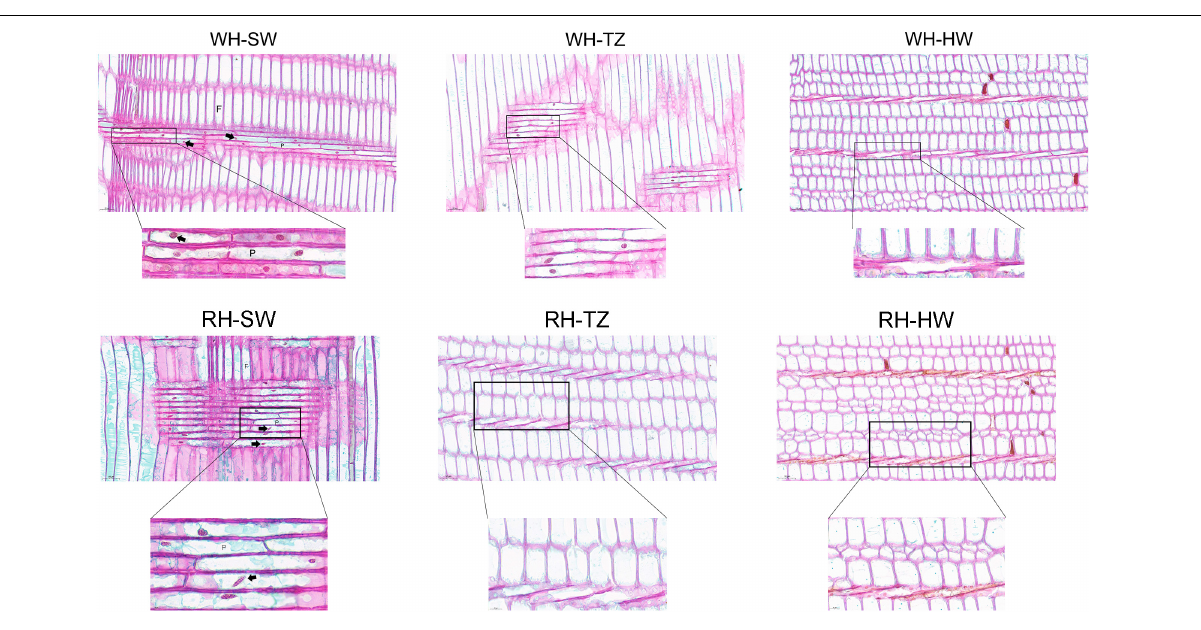
largest number of unigenes ( Supplementary Figure 2 ). The clusters of orthologous groups of protein database (COG) annotation allocated 129,056 unigenes into 25 COG categories ( Supplementary Figure 3 ). The general function prediction